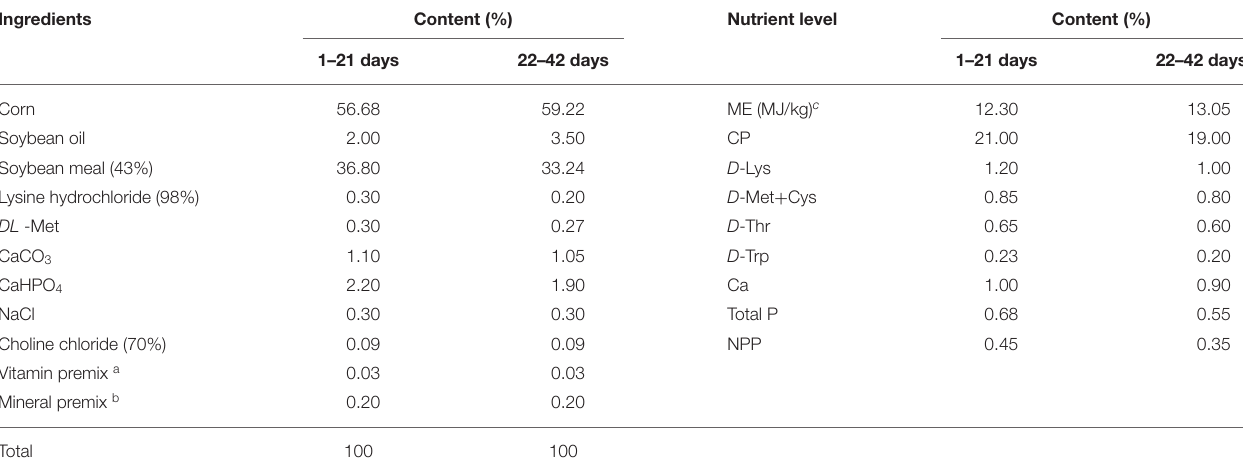
TABLE 1 | Composition and nutrient levels of basal diets (air-dry basis). Ingredients